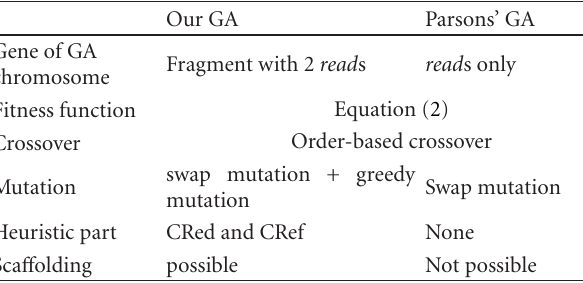
Table 2: The di ff erences between proposed GA and Parsons’